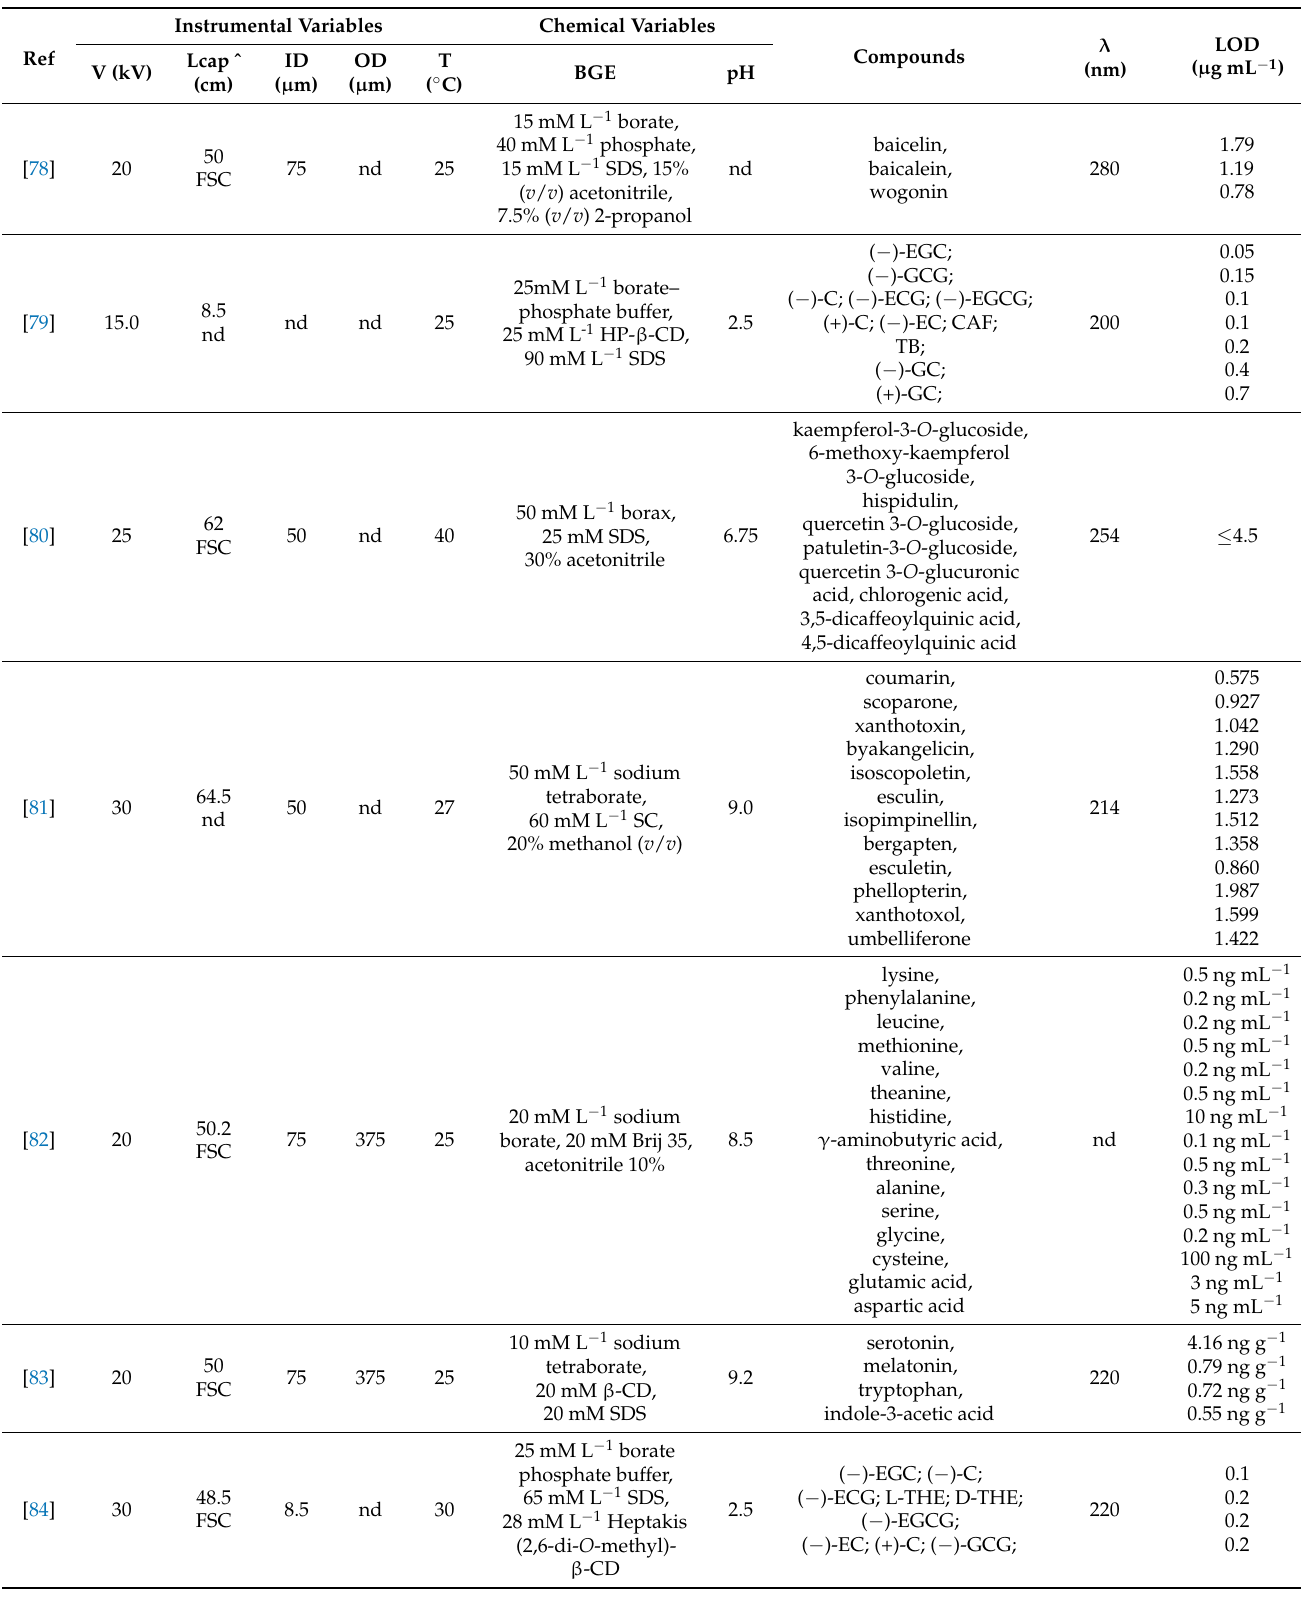
Table 5. Application of micellar electrokinetic